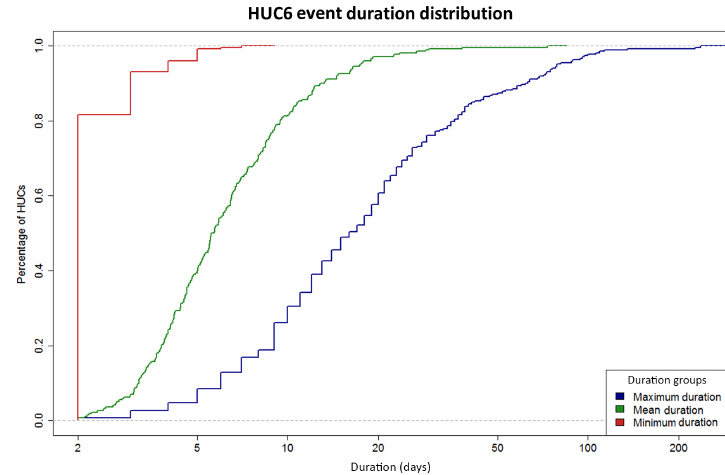
Figure 9. HUC6 event duration CDF.